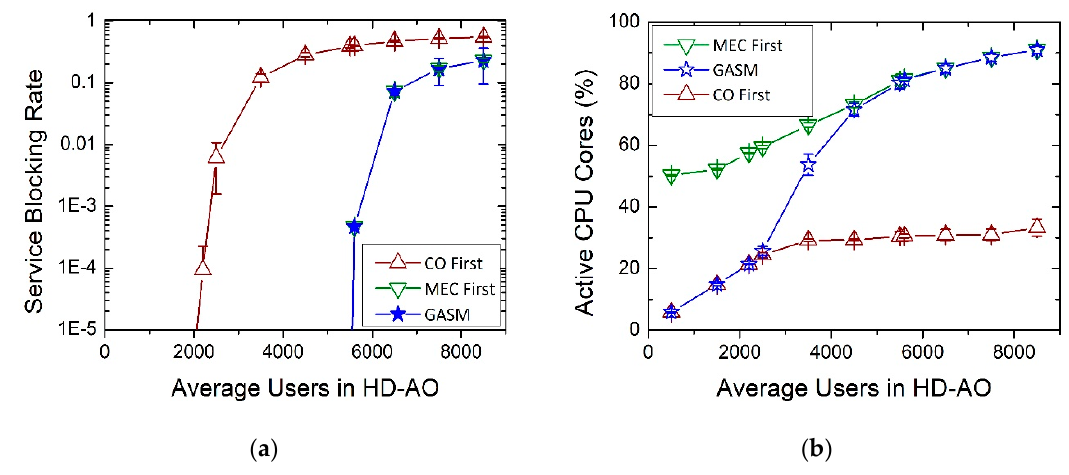
Figure 3. ( a ) Service Blocking Rate and ( b ) Percentage of CPU cores in use for Genetic Algorithm for Service Mapping (GASM), MEC-First and CO-First in a static scenario.